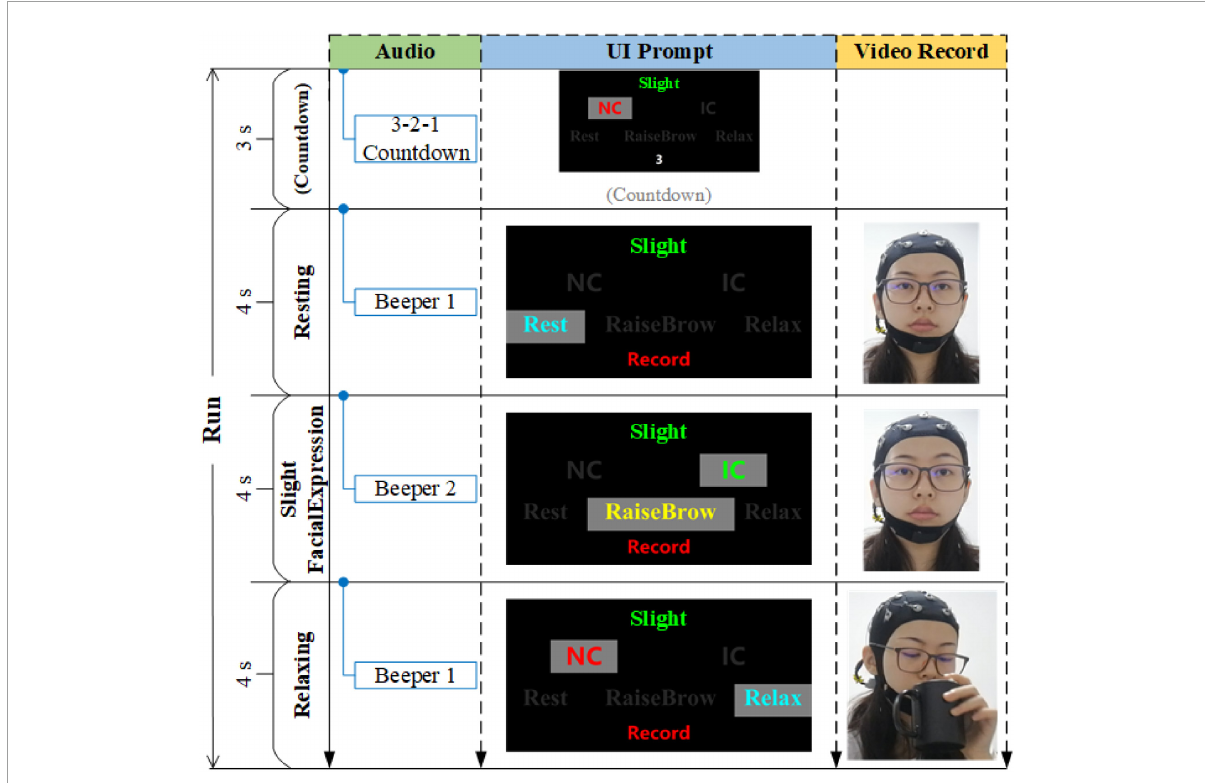
FIGURE3 The timing diagram of one trial, where IC represents “in-control,” and NC represents